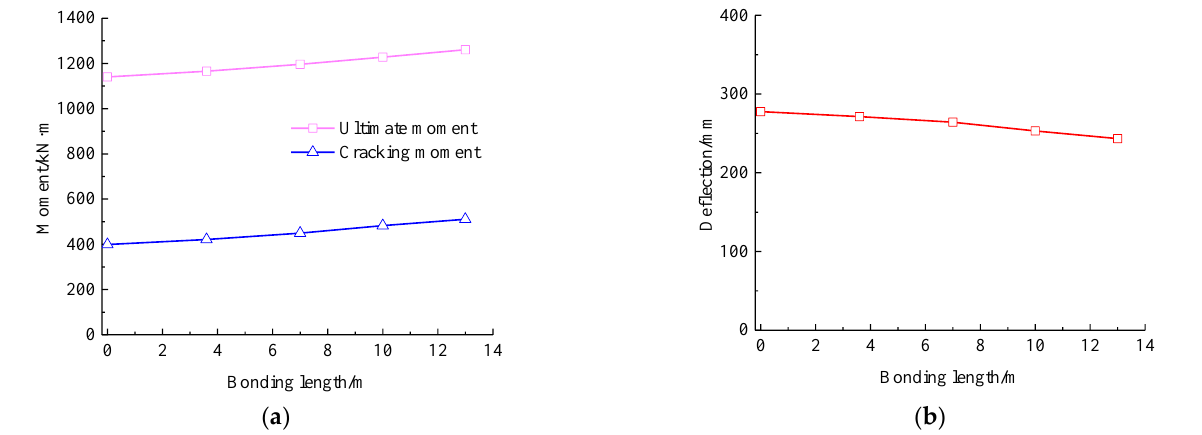
Figure 18. Influence of CFRP bonding length on response of the strengthened beam: ( a ) cracking and ultimate moments; ( b ) ultimate mid-span deflection.